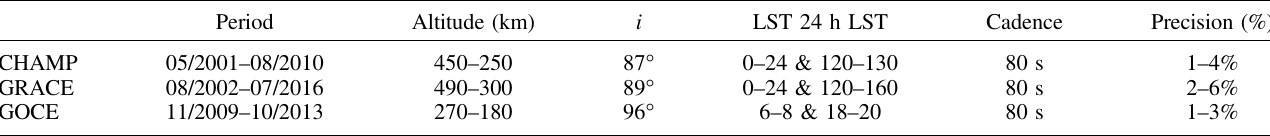
Table 2. Datasets selected for the model assessment under storm conditions ( i is inclination, and LST is the local solar time coverage and the approximate period, in days, to cover 24 h).